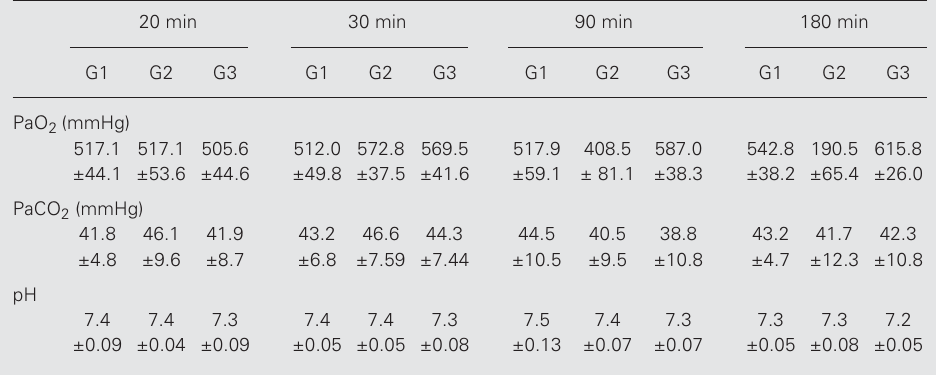
Table 2. Arterial blood gases of rats during mechanical ventilation in the presence and absence of pentoxifylline. 20 min 30 min 90 min 180 min G1